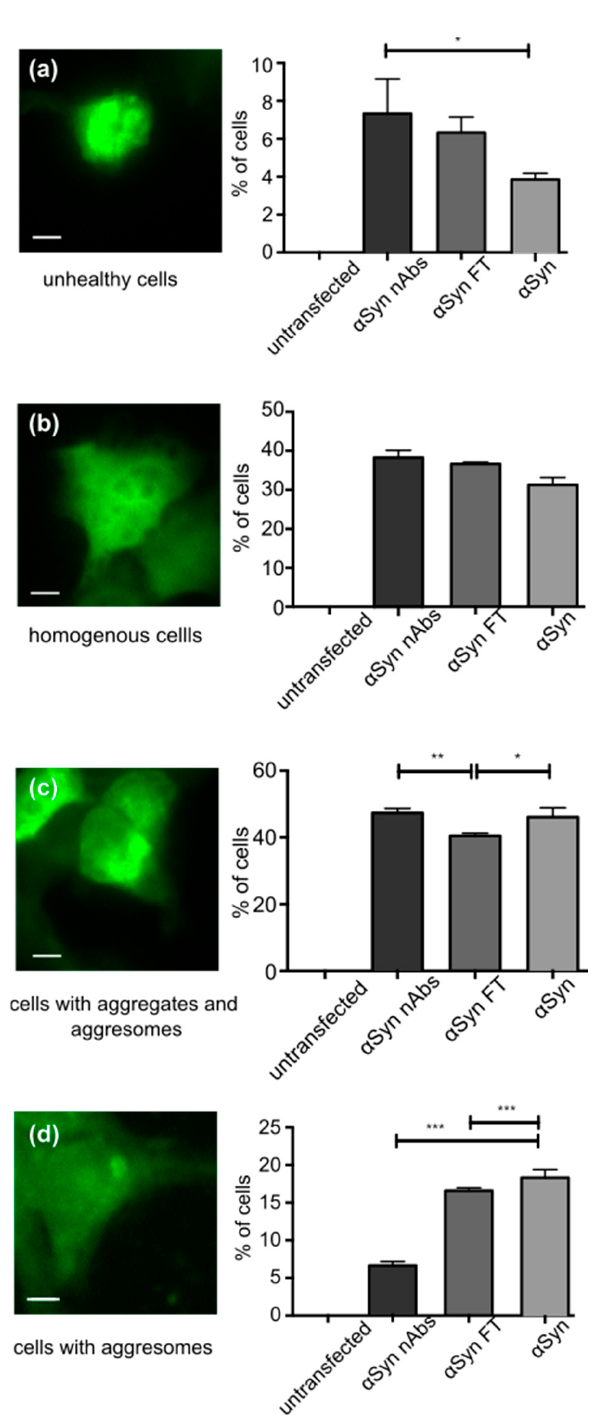
Figure 3. Effect of nAbs- α Syn on GFP-tagged α Syn in HEK293T cells. HEK293T cells were transfected with α Syn flexibily tagged by GFP, grown for 24 h and then treated with nAbs- α Syn for another 24 h. ( a – d ) First row, example images of cells in the following categories into which cells were manually classified: Unhealthy cells ( a ), cells with homogenous GFP fluorescence ( b ), cells with aggresomes and aggregates ( c ), cells with aggresomes ( d ). Scale bar represents 5 μ m. ( a – d ) Second row, quantification of n = 3 experiments with at least 100 cells classified for each condition. FT: flow through. Bars represent p values from three replicates as calculated with one-way ANOVA. * p < 0.05, ** p < 0.01, *** p < 0.001.